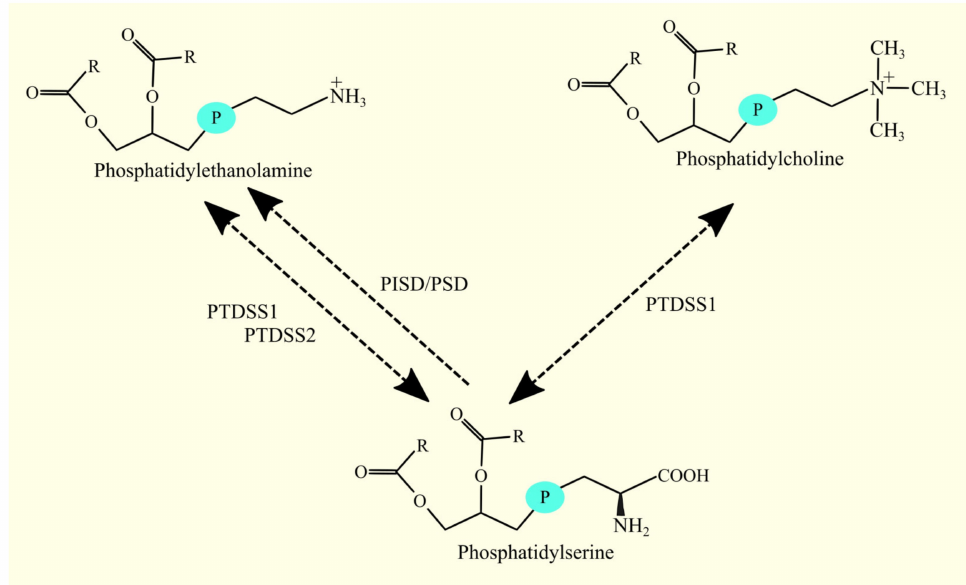
Figure 8. Biosynthesis of PS. Ethanolamine and choline in PE and PC can be exchanged for serine by PTDSS1 and PTDSS2, resulting in the formation of PS. PS can also undergo decarboxylation by PISD/PSD, converting this glycerophospholipid into